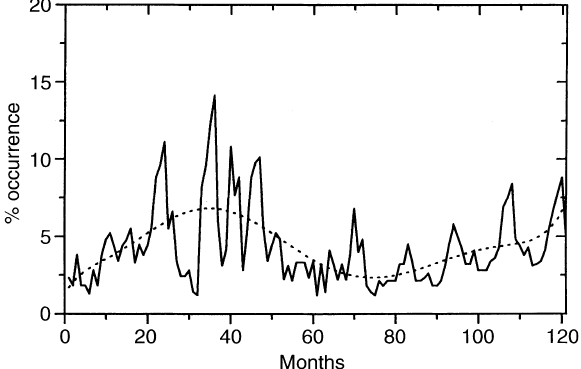
Fig. 3. Variation of monthly mean percentage occurrence of daytime scintillations for the period 1983–1993